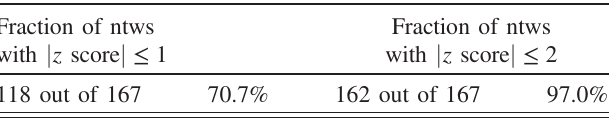
TABLE III. Fraction of networks whose discrepancy between the real and randomized nestedness is less than or equal to 1 σ or 2 σ for nestedness measures performed with the stable